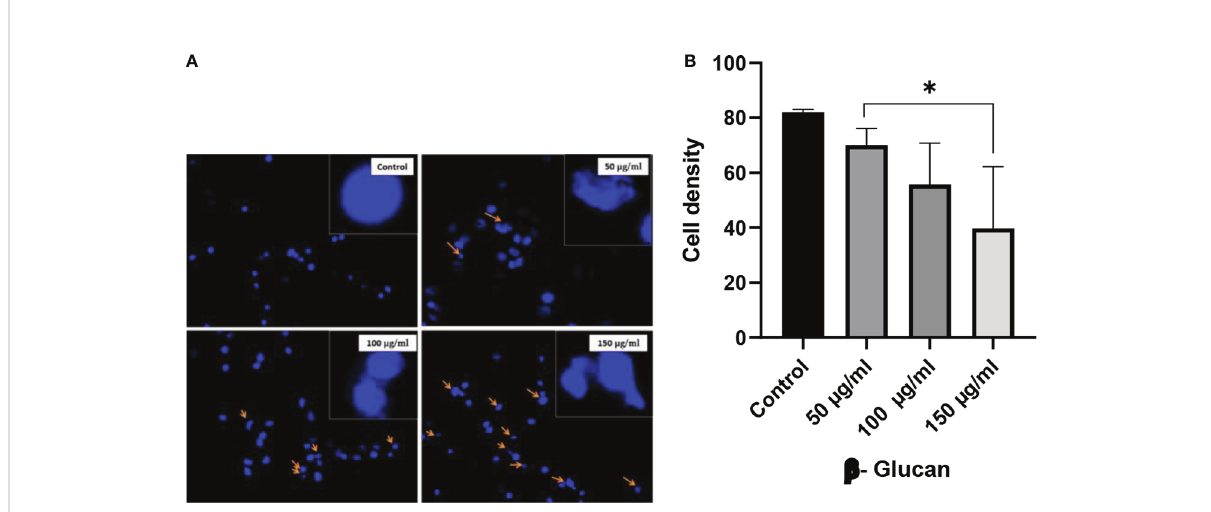
FIGURE 11 (A) Fluorescence microscopy images of HeLa cells stained with DAPI. In control well, nucleus was found intact and in regular shape, while in treatment wells, nucleus fragmentation and morphological changes were observed. These changes were increased with the increasing concentration. The arrows show chromatin and DNA fragmentation due to yeast b -glucan treatment. (B) One-way ANOVA performed with the help of GraphPad Prism 8.0 software showing all the treatments signi fi cant with p-value = 0.0276 (p < 0.05). Quantitative estimation was performed with ImageJ software. **less signi fi cant.